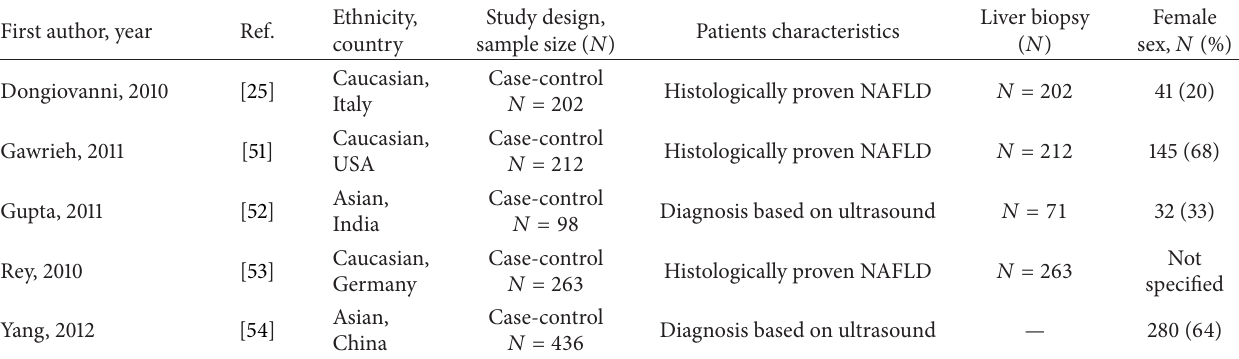
Table 2: Characteristics of the studies on the association between the Pro12Ala variant of PPAR 𝛾 and nonalcoholic fatty liver disease. First author,